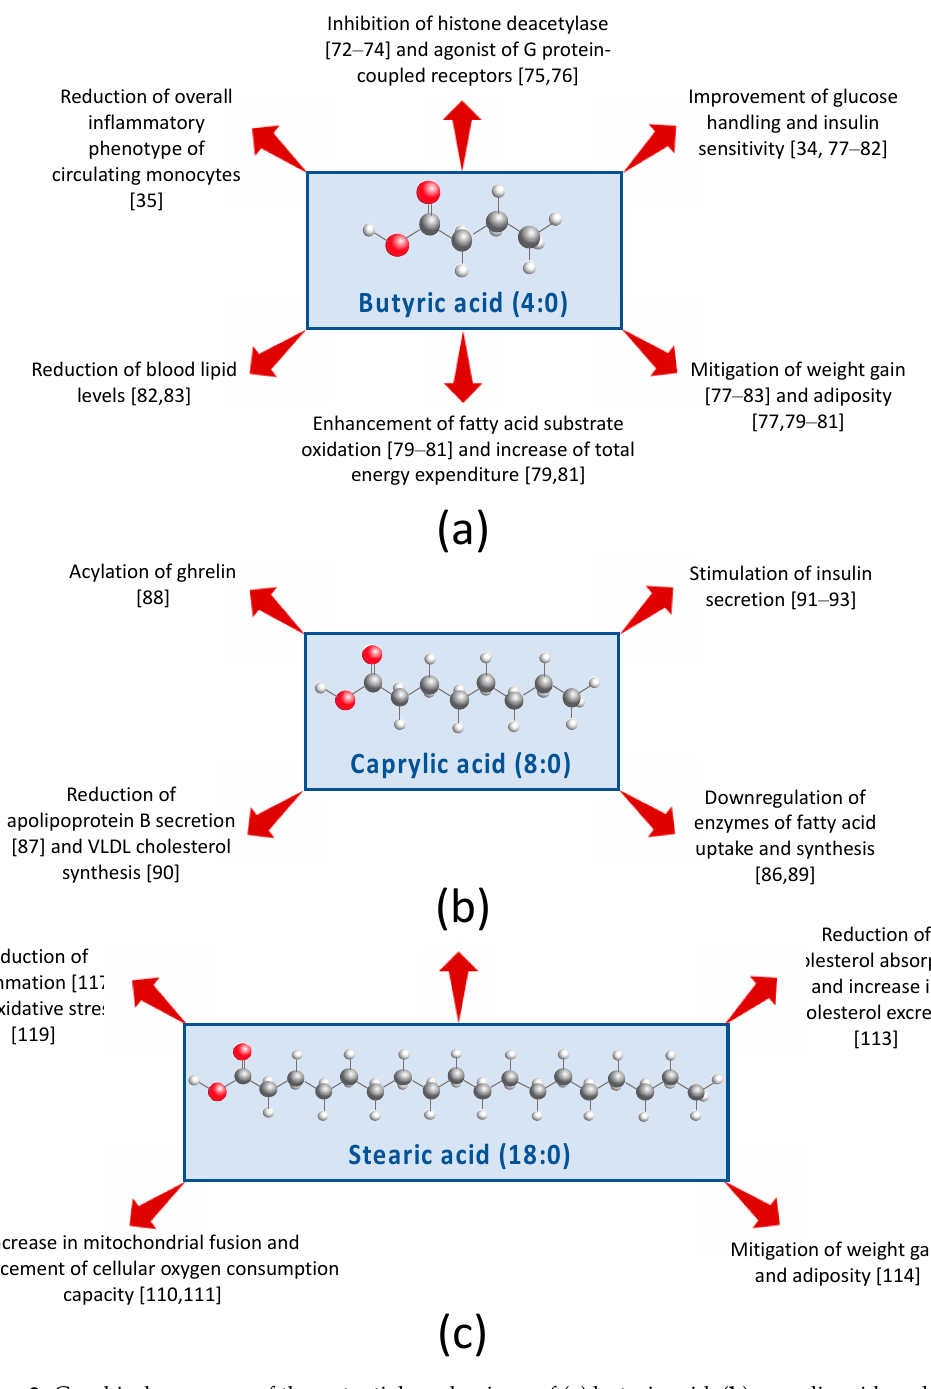
Figure 2. Graphical summary of the potential mechanisms of ( a ) butyric acid, ( b ) caprylic acid, and ( c ) stearic acid that beneficially modulate risk of metabolic syndrome.